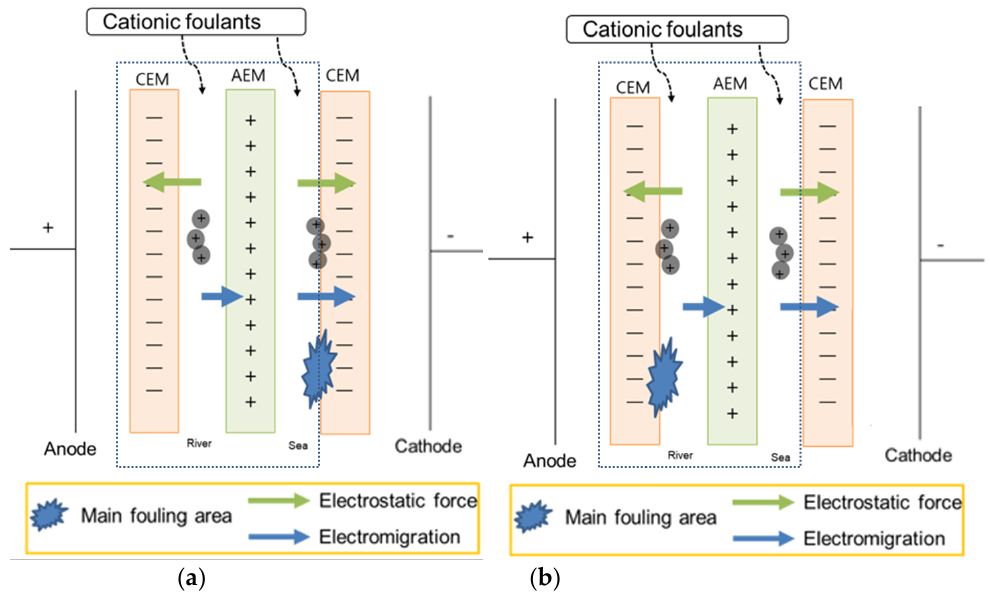
Figure 6. Illustration of showing ( a ) the hypothesis and ( b ) the experimental result of the RED system with only one cell pair (the part within the dashed square) supplying seawater and river containing cationic foulants.